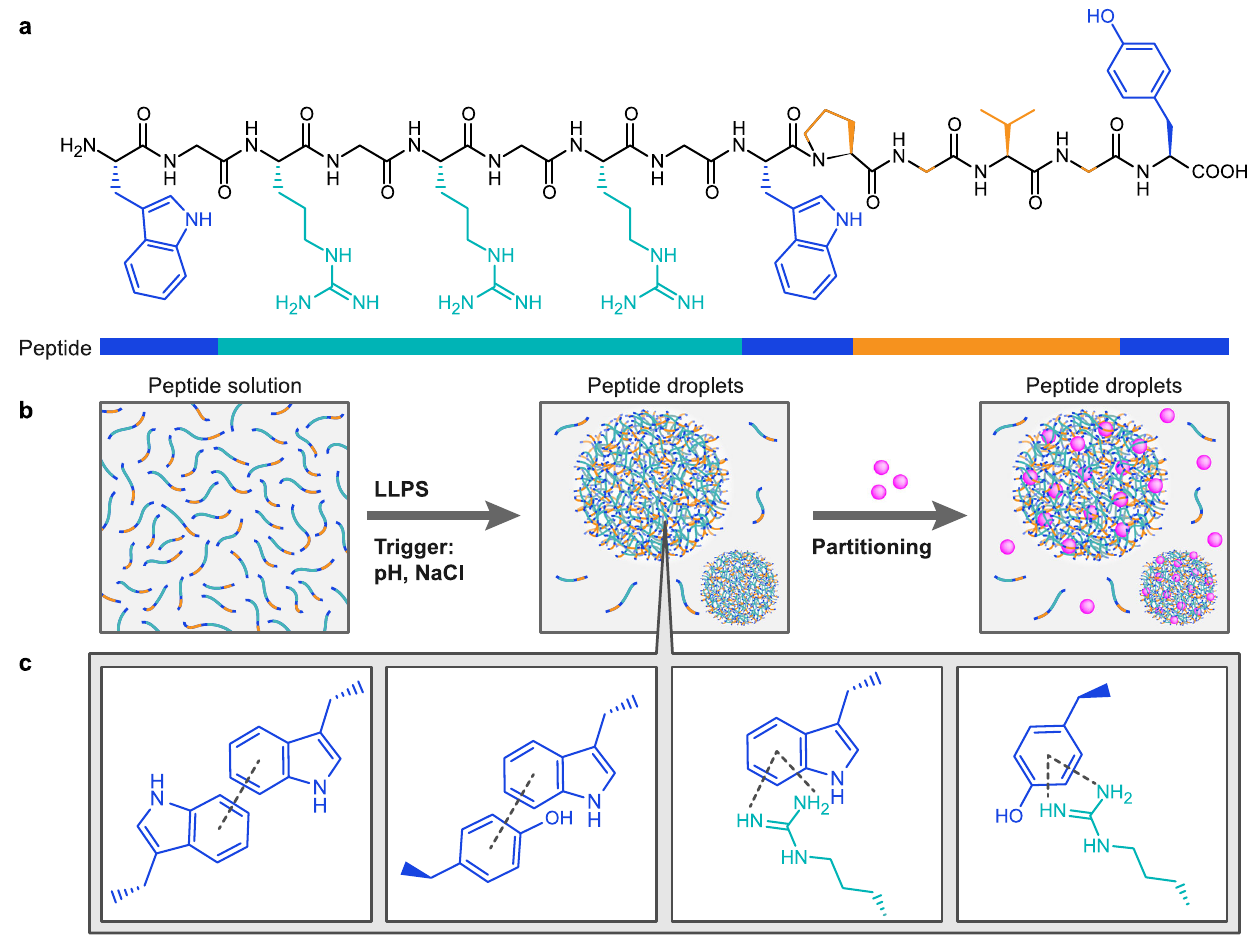
Fig. 1 | Designer minimalistic peptide droplets. a Chemical structure of WGR-1. Aromaticaminoacidsidechains(TrpandTyr)arecoloredinblue,Argsidechainis colored in turquoise, and non-polaramino acidside chainsthat are partofthe ELP domain (Pro-Gly-Val-Gly) are colored in orange. b Suggested mechanism of the peptide liquid droplet formation and subsequent partitioning of fl uorescent